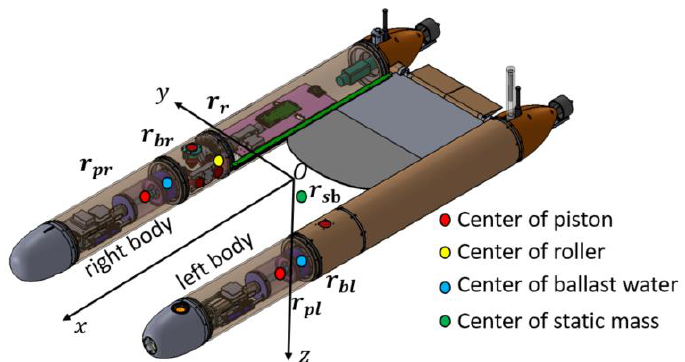
Figure 2. Mass distribution and descriptions